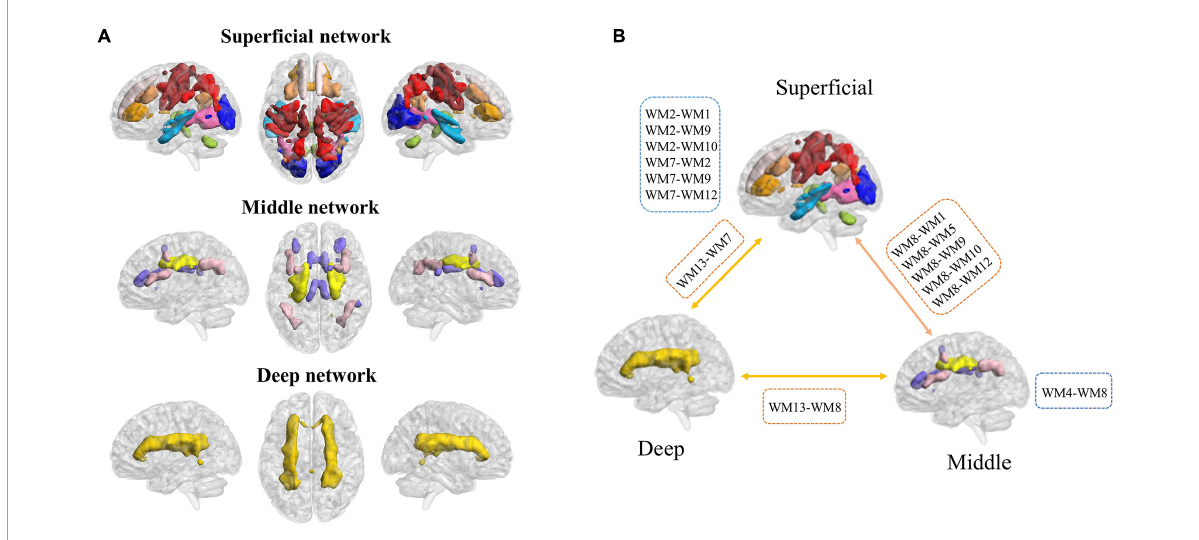
FIGURE3 Three layers of functional white-matter networks. (A) Three layers were defined based on the spatial distance to the gray-matter (superficial, middle, and deep). (B) The increased intra-layer and inter-layer connections of functional white-matter networks showed in myotonic dystrophy type 1 (DM1). The blue dashed boxes represent increased FC between functional white-matter networks in the intra-layer, while the orange dashed boxes represent increased FC between functional white-matter networks in the inter-layer.